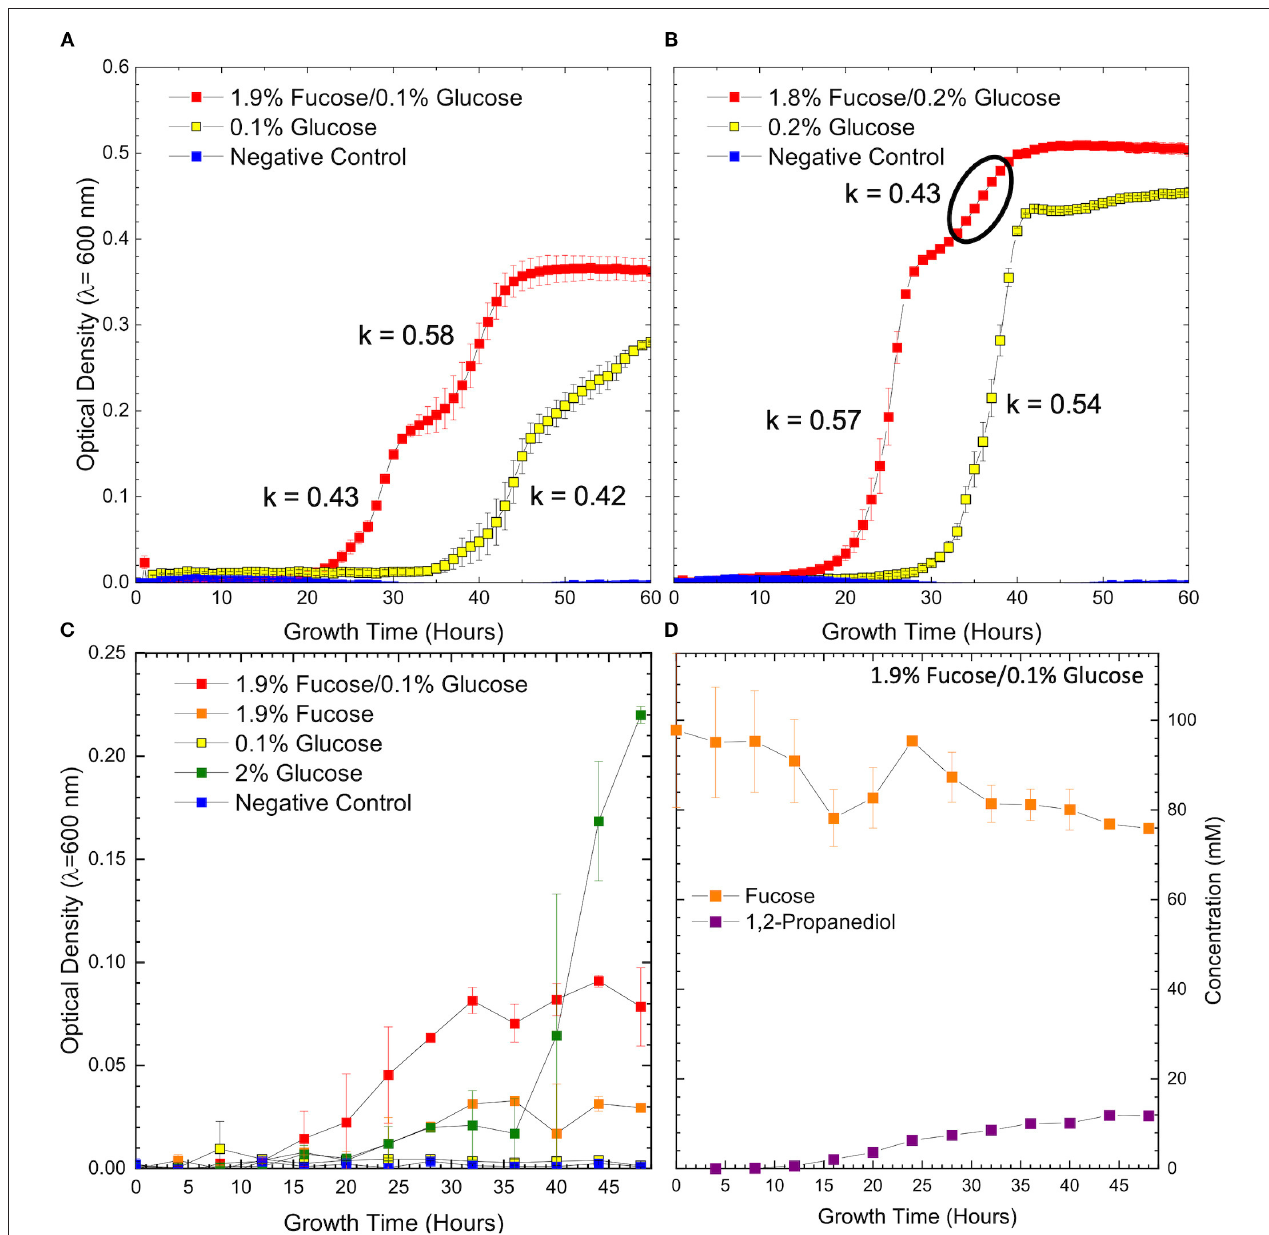
FIGURE 1 | Growth curves of ATCC 15697 in (A) co-fermentation of 1.9% fucose and 0.1% glucose, (B) co-fermentation of 1.8% fucose and 0.2% glucose and on a corresponding concentration of glucose as a sole carbohydrate source shows distinct changes in growth rate during co-fermentation. The region where growth kinetics deviate and are best fit with a second growth rate is noted by the bold circle. Growth curves of ATCC 15697 on (C) co-fermentation of 1.9% fucose and 0.1% glucose and on individual carbohydrate sources. Samples were analyzed for metabolite concentrations at each data point. Concentrations of fucose and 1,2-propanediol (D) during co-fermentation of 1.9% fucose and 0.1% glucose are inversely related and in stoichiometric agreement with the proposed fucose metabolic pathway. Error bars denote standard error of the mean.